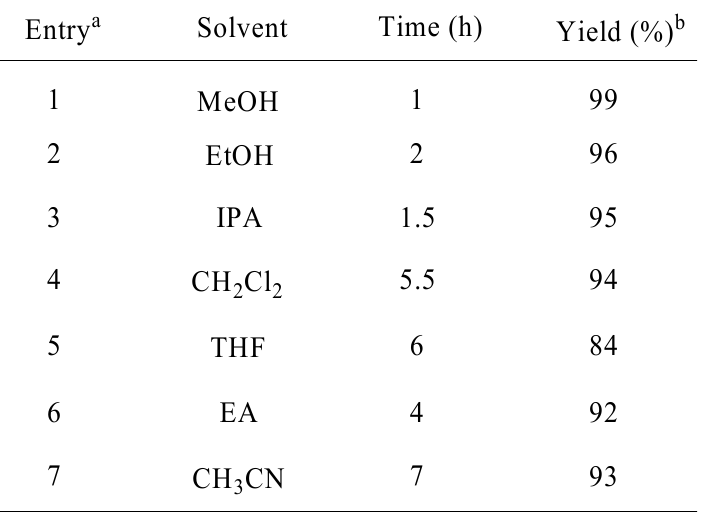
Table 1. Solvent effects in the